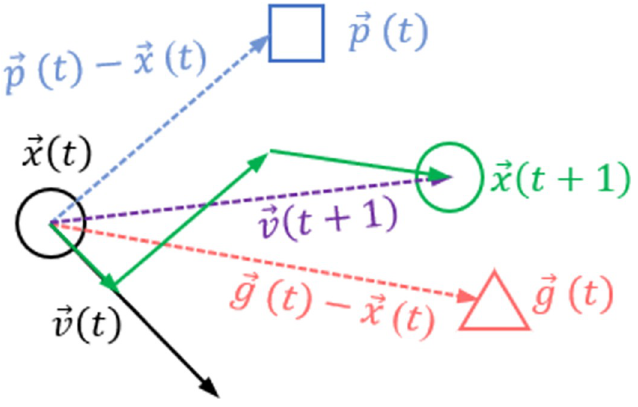
Fig 1. Particle flight velocity